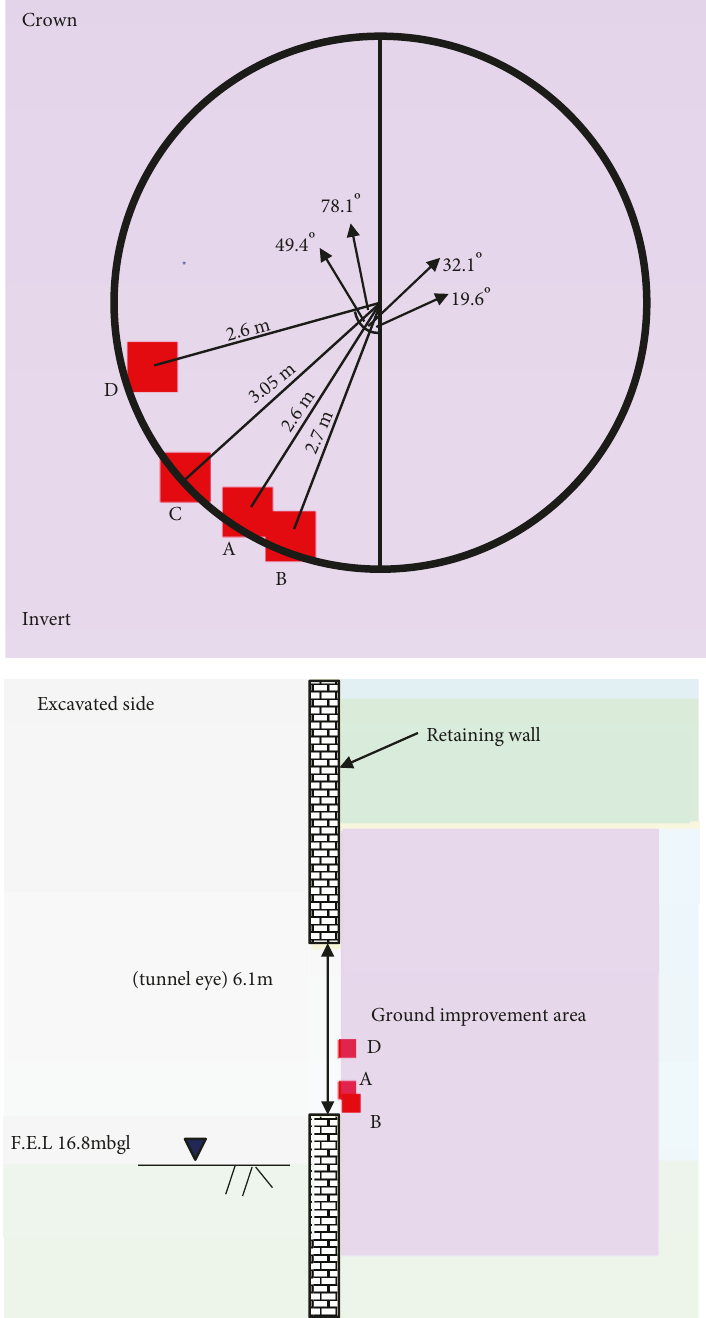
Figure 6: Failure points during the launching of a shield (transverse section immediately behind the